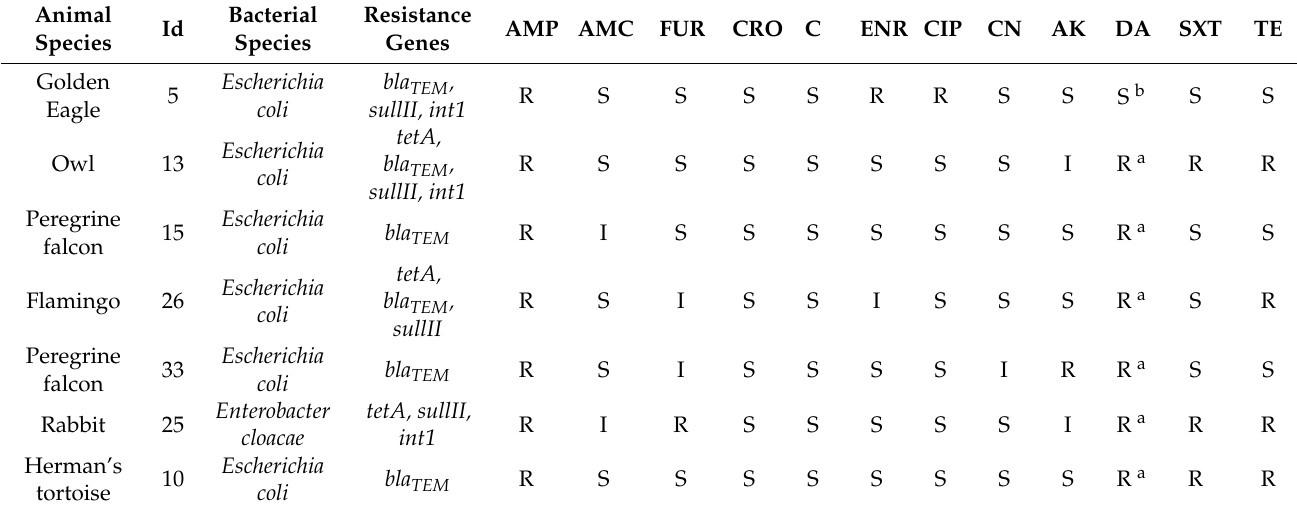
Table 5. Resistance genes and antibiograms with the Kirby–Bauer method ( n =